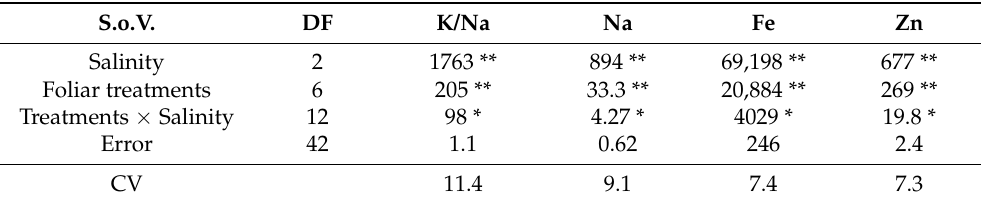
Table 6. ANOVA for the effect of salinity and foliar application (without spraying, potassium nitrate, and Zn and Fe nanoparticles) on Na, Fe, and Zn content and K/Na ratio of Aloe vera plants. S.o.V. DF K/Na Na Fe Zn Salinity 2 1763 ** 894 ** 69,198 ** 677 ** Foliar treatments 6 205 ** 33.3 ** 20,884 ** 269 ** Treatments × Salinity 12 98 * 4.27 * 4029 * 19.8 * Error 42 1.1 0.62 246 2.4 CV 11.4 9.1 7.4